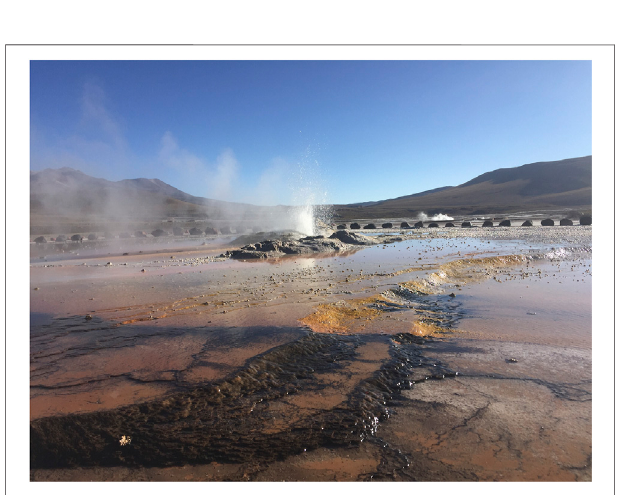
FIGURE 3 | El Tatio ancestral territory. Author: Manuel Tironi. FIGURE 4 | Hécar (Iticunza) and Laguna Verde (Iticuna) volcanoes. Author: Manuel Tironi.